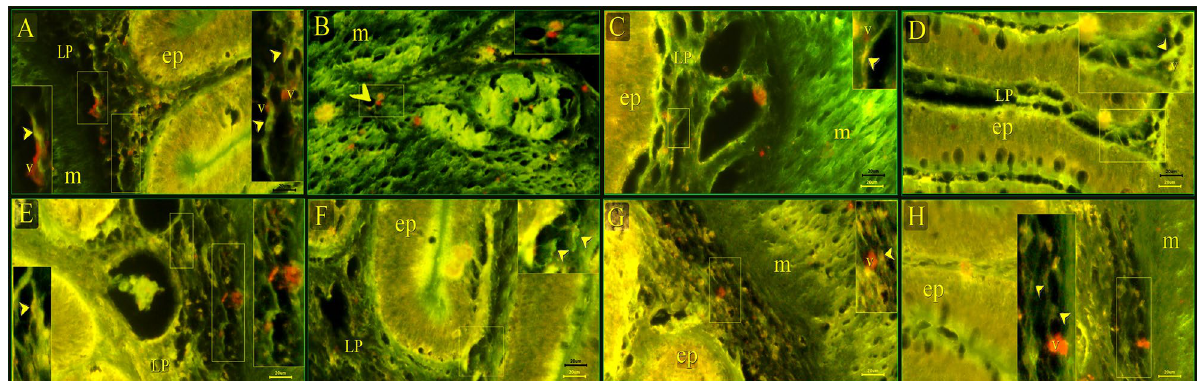
Figure 7. Recognition of TCs using Acridine orange. ( A , C , E , G , H ) TC in the lamina propria (arrowhead). Note secretory vesicle (v) associated with TC. ( B ) intramuscular TC (arrowhead). Note the secretory vesicle (v) associated with TC. ( D , F ) subepithelial TC (arrowhead). Note secretory vesicle (v) associated with